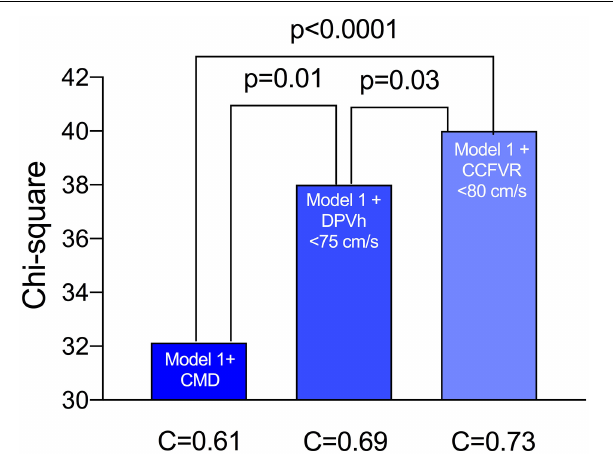
FIGURE 6 | Performance of various survival prediction models among HT patients. Age at transplant, time post-transplant, onset of CAV, donor age and ischemic time are independent predictors of survival (referred to as Model 1). We evaluated the incremental prognostic value of CMD (defined as CFVR < 2.5), DPV h < 75 cm/s and CCFVR < 80 cm/s to Model 1 and found that CCFVR is significantly more accurate than CMD ( p < 0.0001) and DPV h ( p = 0.03). The inclusion of CCFVR to clinical predictors of mortality permitted therefore better prediction of survival among HT